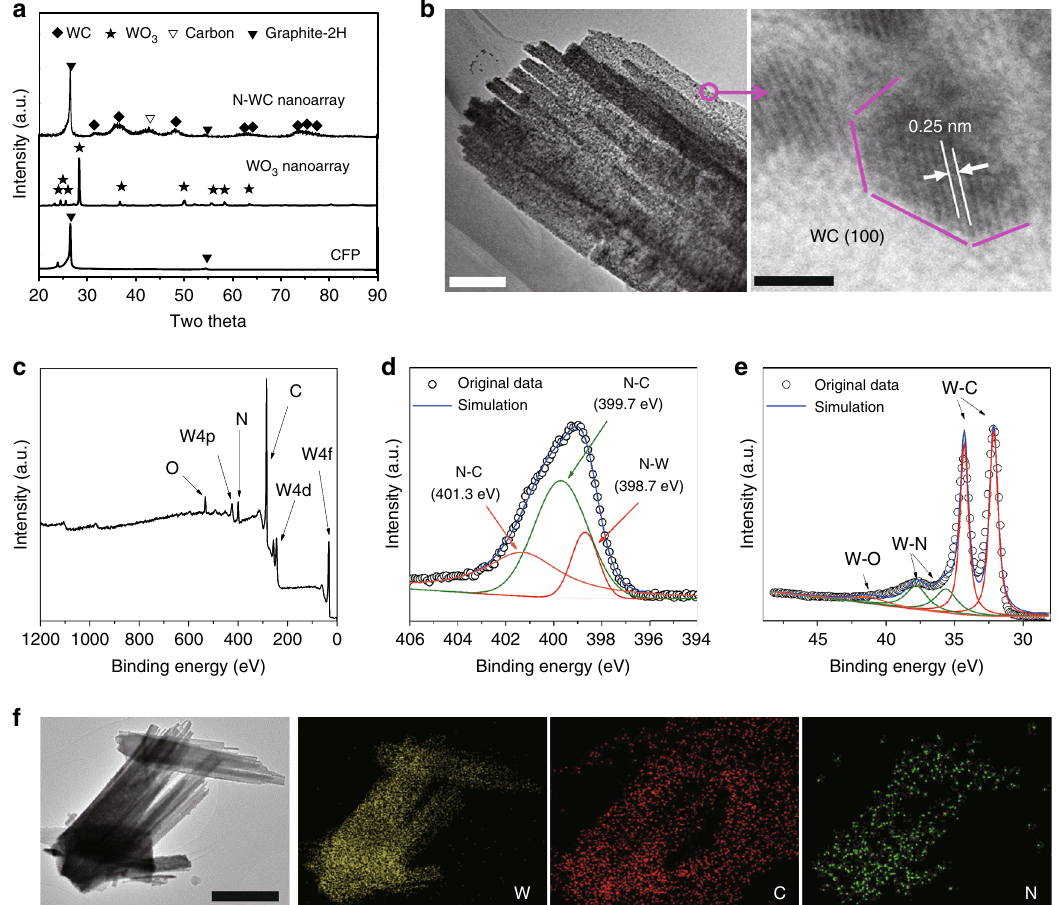
Fig. 3 Characterization of N-WC nanoarray electrode. a XRD patterns of CFP and the synthesized WO3 nanoarray and N-WC nanoarray. b HRTEM of N- WC nanoarray. c XPS survey of N-WC nanoarray, and high-resolution XPS of d N 1s and e W 4f. f TEM-EDS element distribution of N-WC nanoarray. Scale bar in b : left 200 nm, right 2 nm. Scale bar in f 1 μ Figure 3f and Supplementary Table 1 show the TEM-EDS result and the corresponding element distribution of N-WC nanoarray. As shown in elemental mapping, N is uniformly distributed along the N-WC nanobelts. The TEM-EDS spectrum of N-WC nanoarray is displayed in Supplementary Fig. 8.